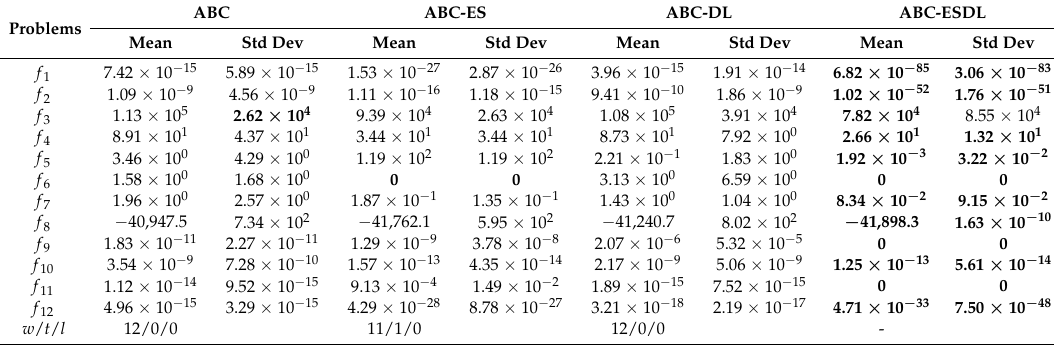
Table 6. Comparison of ABC with different strategies ( D =